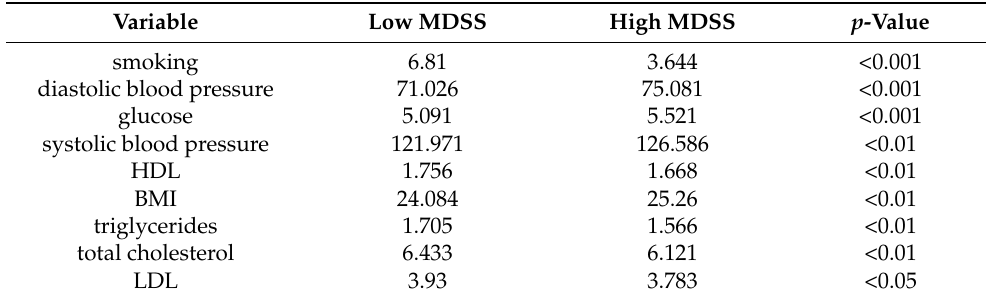
Table 3. Association of biological and lifestyle characteristics with the Mediterranean Diet Serving